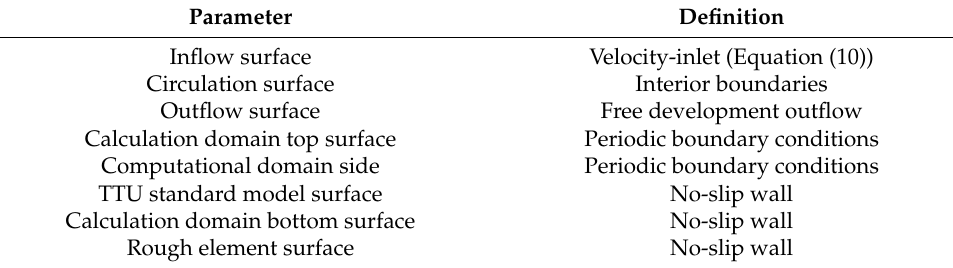
Table 1. Setting of boundary